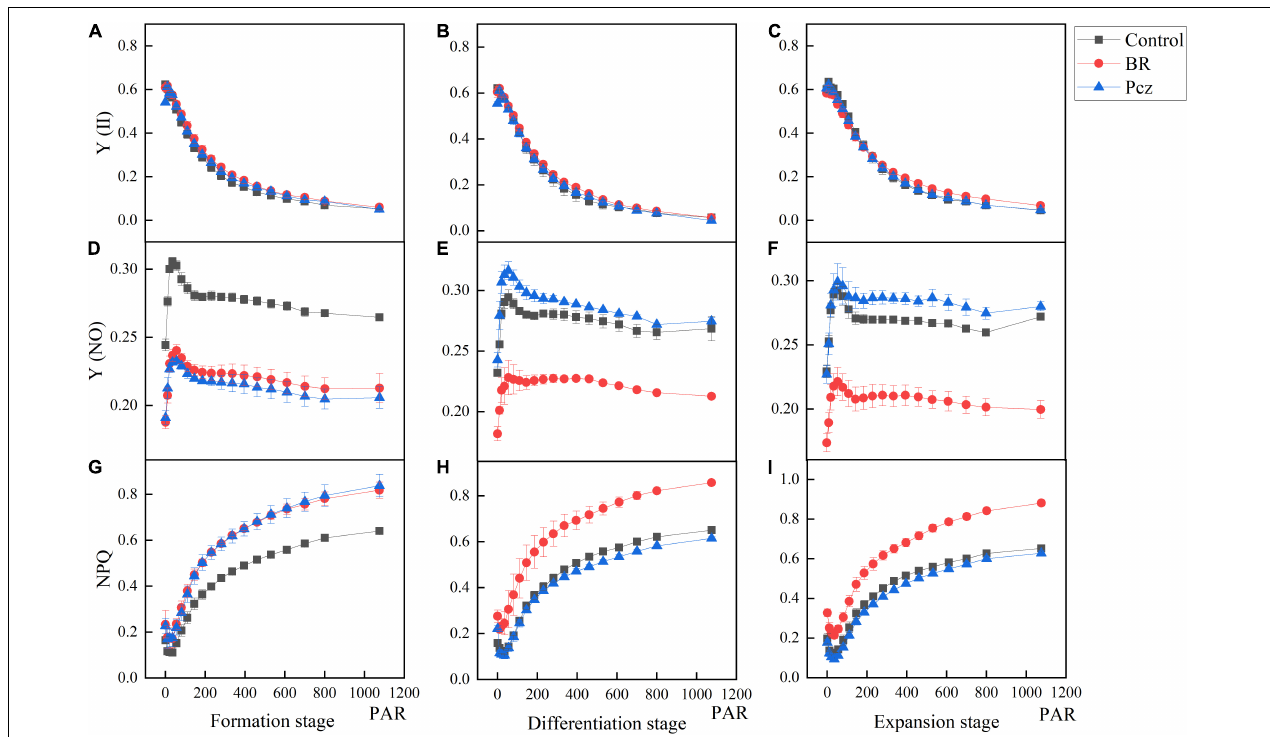
FIGURE 6 | Chlorophyll fluorescence light response curve of P. ternata under BR and PCZ treatment. (A–C) Light-response of Y (II) at formation stage, differentiation stage, and expansion stage. (D–F) Light-response of Y (NO) at formation stage, differentiation stage, and expansion stage. (G–I) Light-response of NPQ at formation stage, differentiation stage, and expansion stage. Values are means of four replicates ± SE.